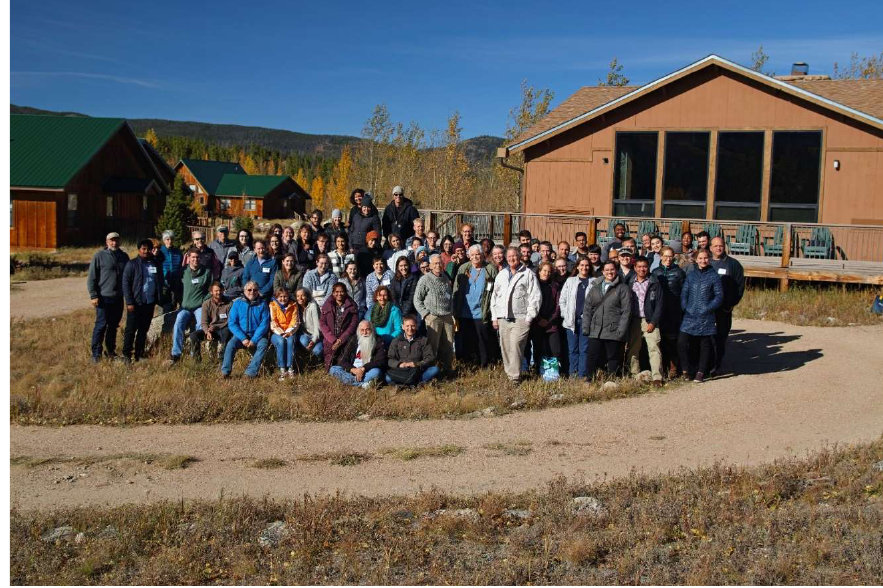
Figure 1. Attendees at the 19th annual Rocky Mountain Virology Association meeting. Viruses 2020 , 12 , x FOR PEER REVIEW